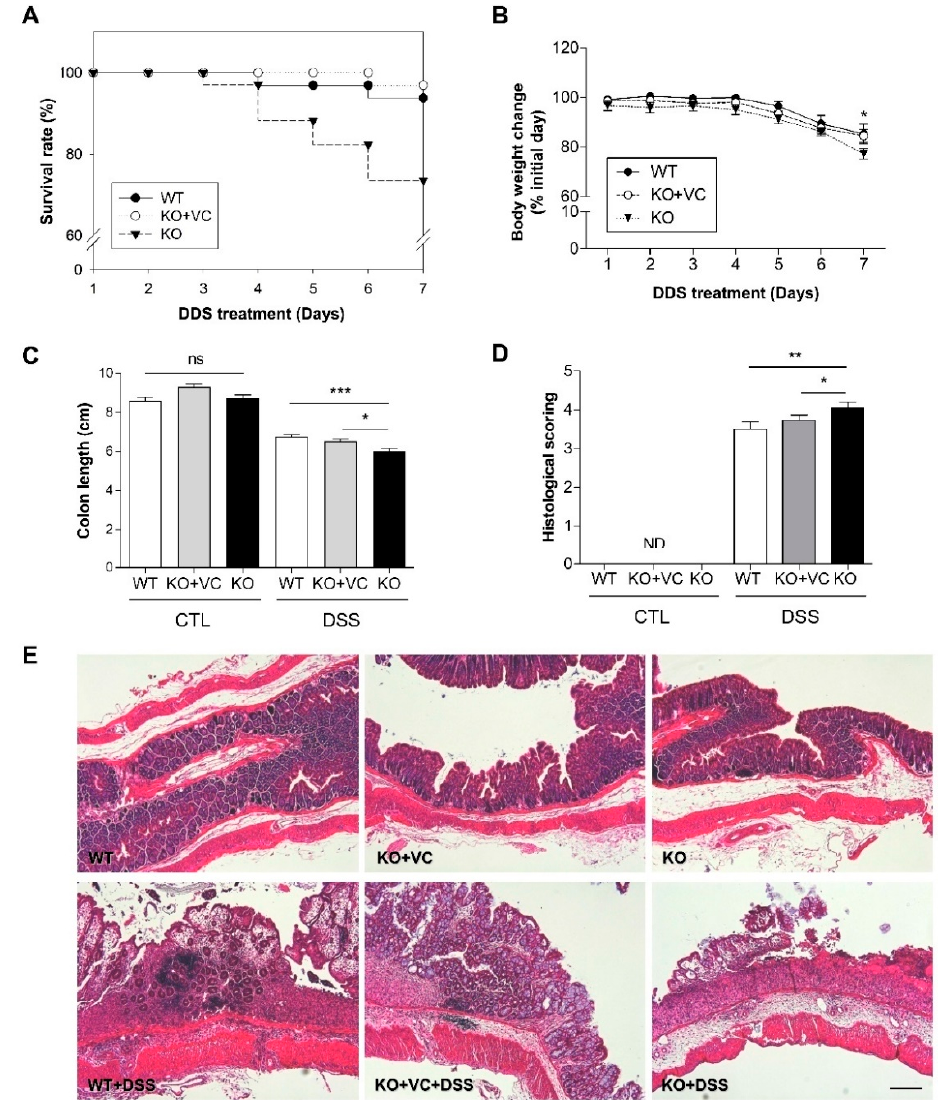
Figure 1. Severe colitis and mortality associated with vitamin C insufficiency and DSS treatment. ( A ) The survival rate and ( B ) body weight of wild-type mice (WT, n = 32), vitamin C-sufficient KO mice (KO + VC, n = 32), and vitamin C-insufficient KO mice (KO, n = 34) were traced for 7 days with 3% DSS treatment. * p < 0.05 (WT vs. KO). ( C ) After DSS treatment for 7 days, colon length was